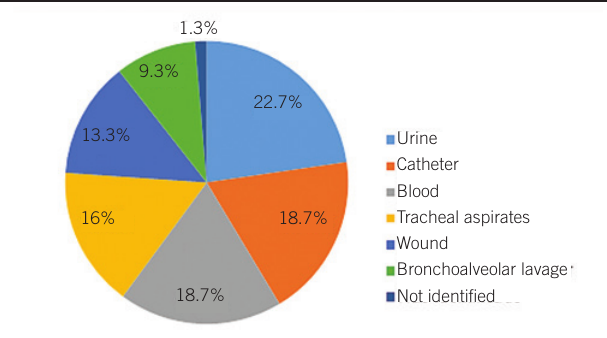
figurE 1 − Percentage of 75 Acinetobacter baumannii isolates from hospital 1 according to the source of specimens